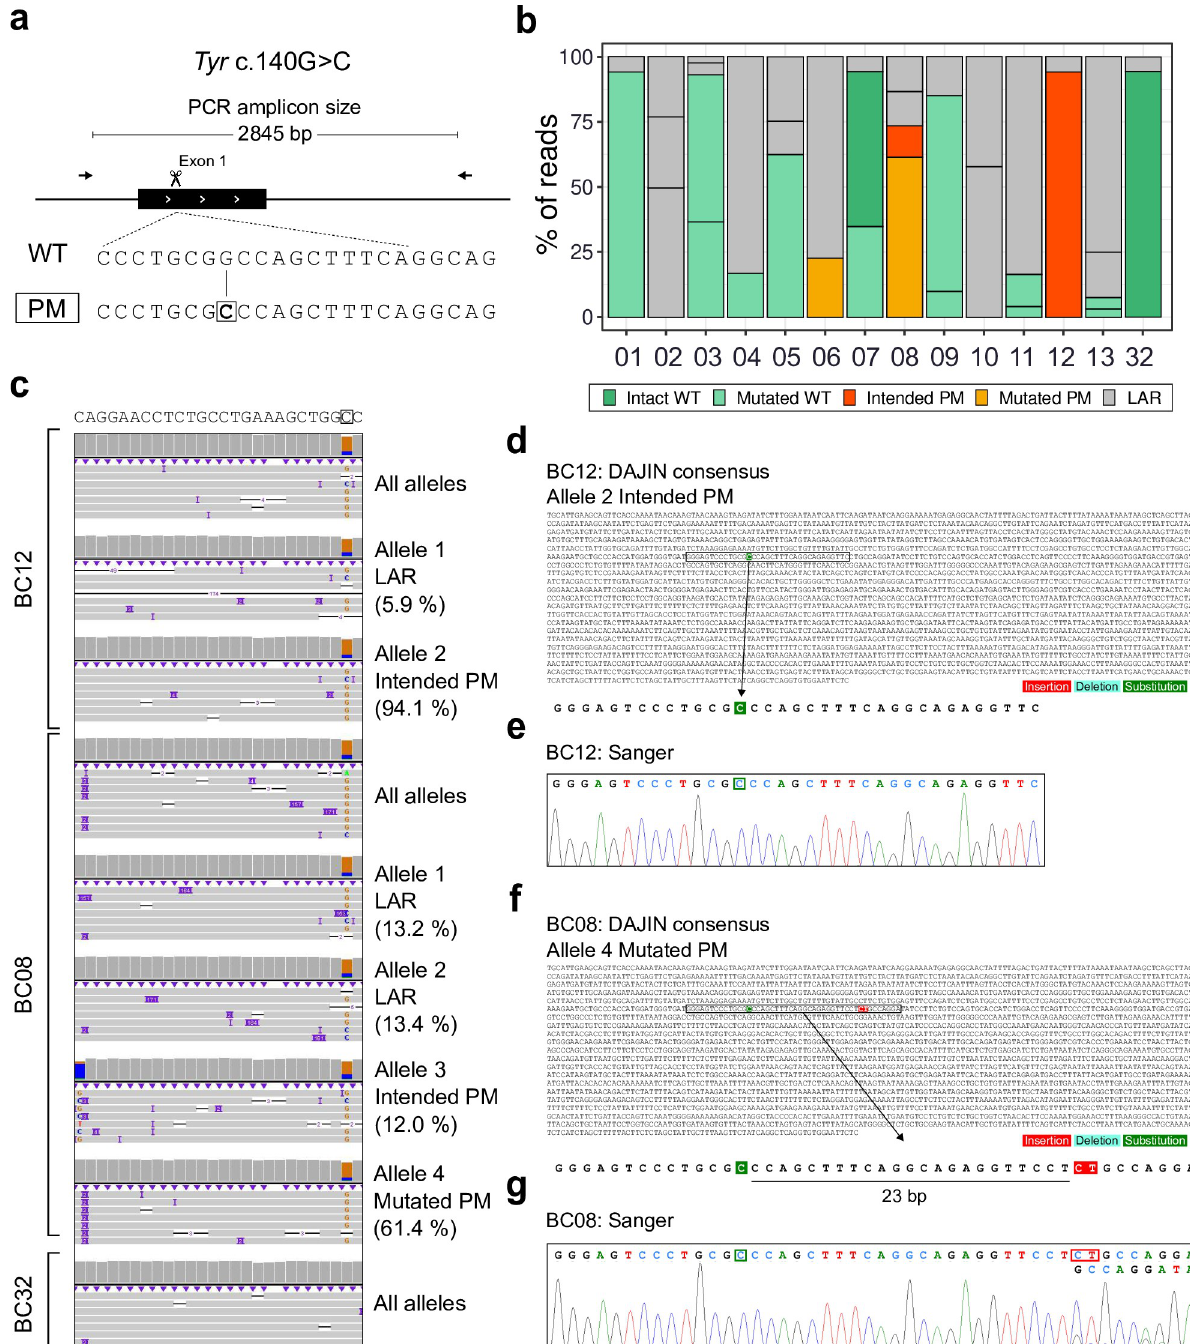
Fig 2. Application of DAJIN for PM design. (a) Genome editing design for Tyr c.140G > C PM. The scissors represent a Cas9-cutting site. The arrows represent PCR primers, including the PCR amplicon size. The boxed allele type represents the target allele, and the boxed nucleotide represents a targeted PM. (b) DAJIN’s report of the allele percentage. The barcode numbers on the x-axis represent mouse IDs. BC32 is a WT control. The y-axis represents the percentage of DAJIN-reported alleles. The colours of the bars represent DAJIN-reported allele types. The compartments partitioned off by horizontal lines in a bar represent the DAJIN-reported alleles. (c) Visualisation of nanopore sequencing reads at Tyr target locus. BC12 and BC08 contain target alleles. BC32 is a WT control. The “All alleles” track represents all reads of each sample. The “Allele” track represents DAJIN-reported alleles. (d) Comparison between DAJIN’s consensus sequence and Sanger sequencing. The sequence represents the consensus sequence of a dominant allele of BC12 and BC08. The colours on the nucleotides represent mutation types, including insertion (red), deletion (sky blue), and substitution (green). The coloured boxes in the Sanger sequence represent mutated nucleotides, including insertion (red) and substitution